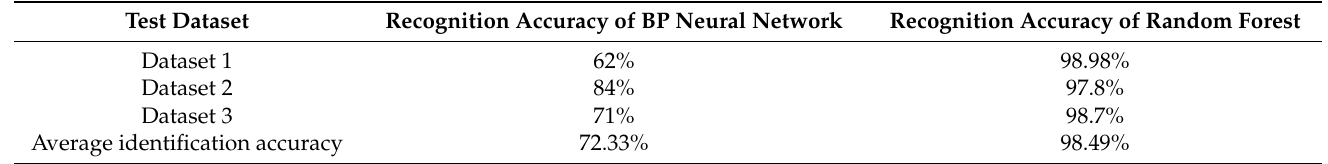
Table 6. Comparison of identification